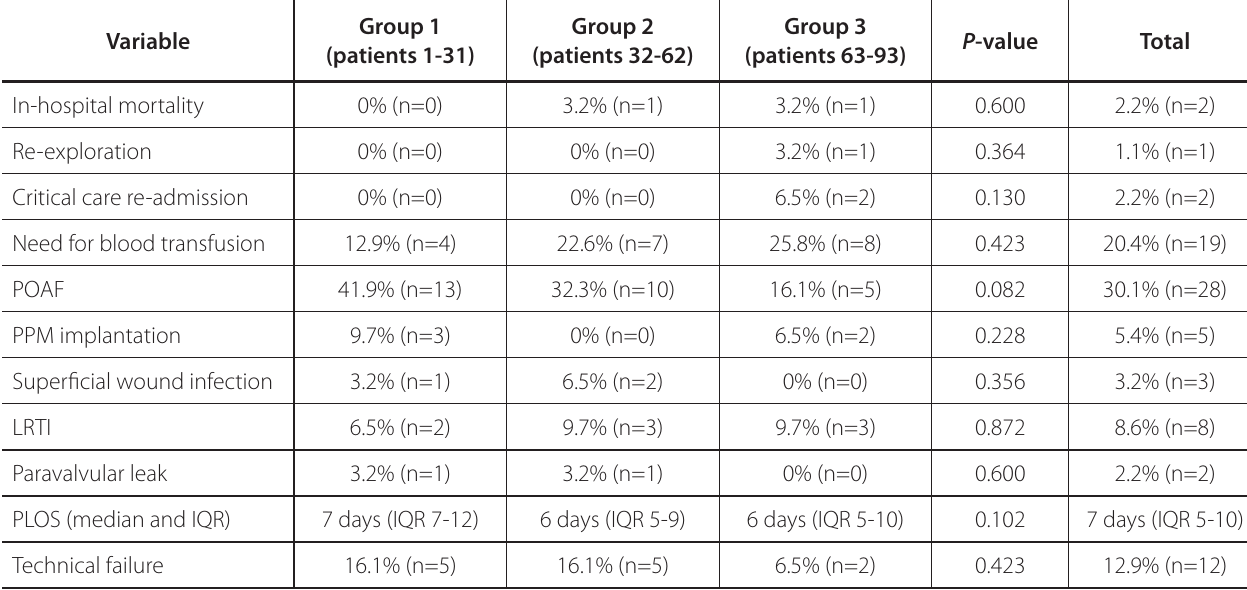
Table 3 . Post-operative outcomes.